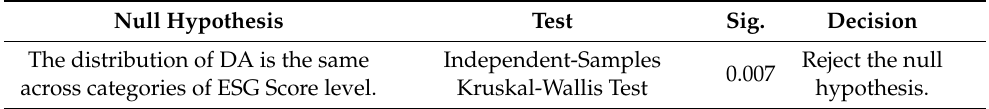
Table 10. Kruskal–Wallis